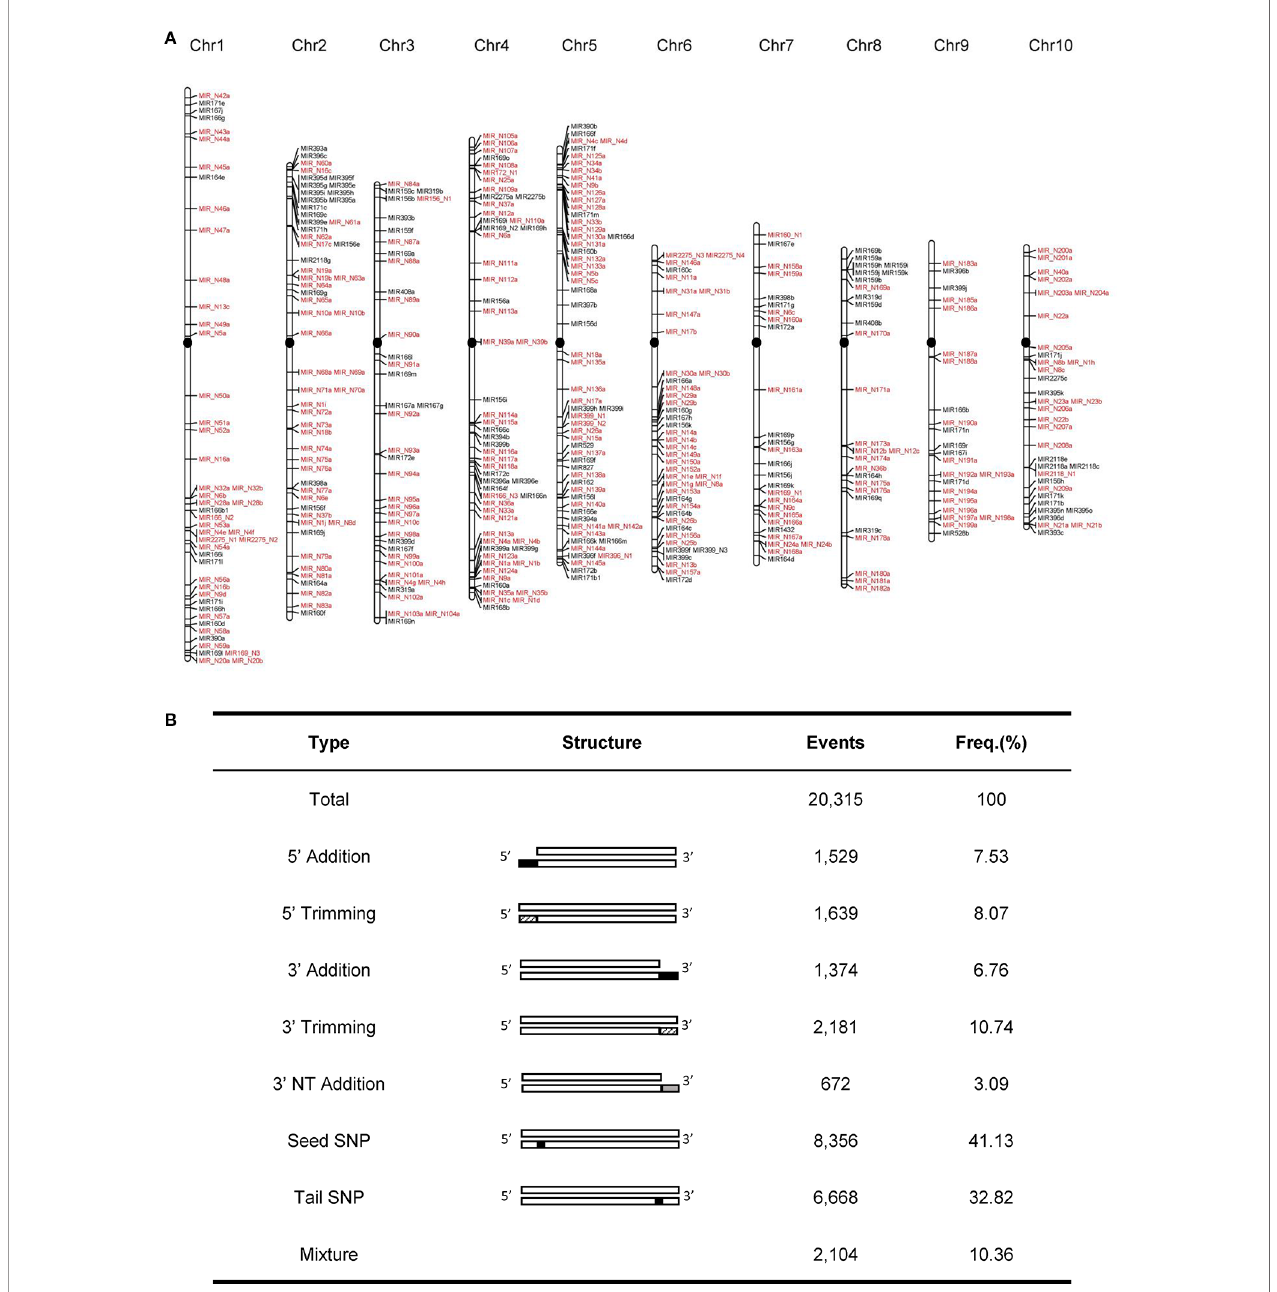
FIGURE 2 | Genome-wide characteristics of maize miRNA genes. (A) Chromosomal distribution of 419 maize miRNA genes. Newly identi fi ed miRNA genes were labeled as red. The black fi lled circles represent centromeres (B) Statistics of different isomiR types in the maize